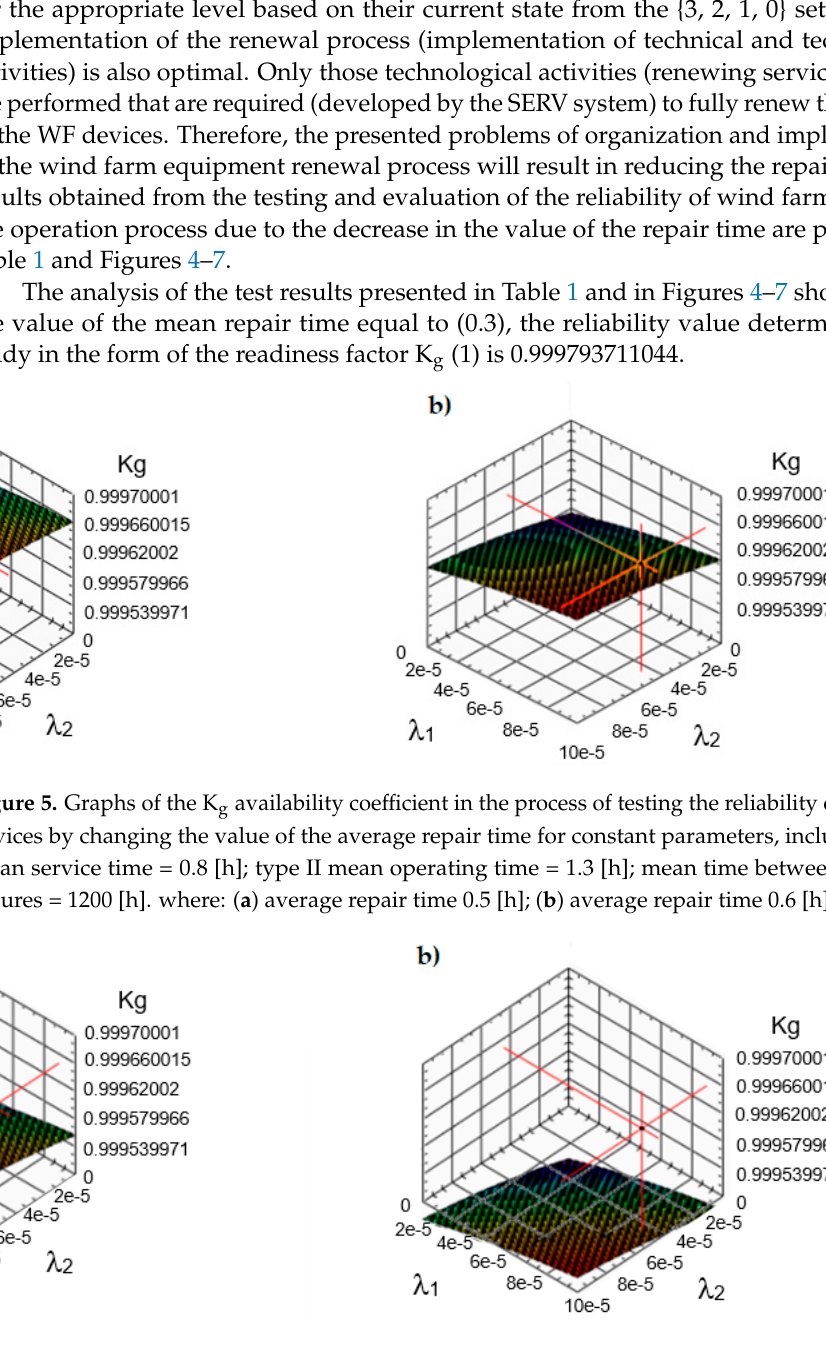
Figure 7. Graphs of the K g availability coefficient in the process of testing the reliability of wind farm devices by changing the value of the average repair time for constant parameters, including: type I mean service time = 0.8 [h]; type II mean operating time = 1.3 [h]; mean time between successive failures = 1200 [h], where: ( a ) mean repair time 0.9 [h]; ( b ) average repair time 1.0 [h]. The analysis of the test results presented in Table 1 and in Figures 4–7 shows that for the value of the mean repair time equal to (0,3), the reliability value determined in the study in the form of the readiness factor K g (1) is 0,999793711044. Table 1. Max. value readiness factor K g . Average Repair Time Value Max. Readiness Factor K g 0.3